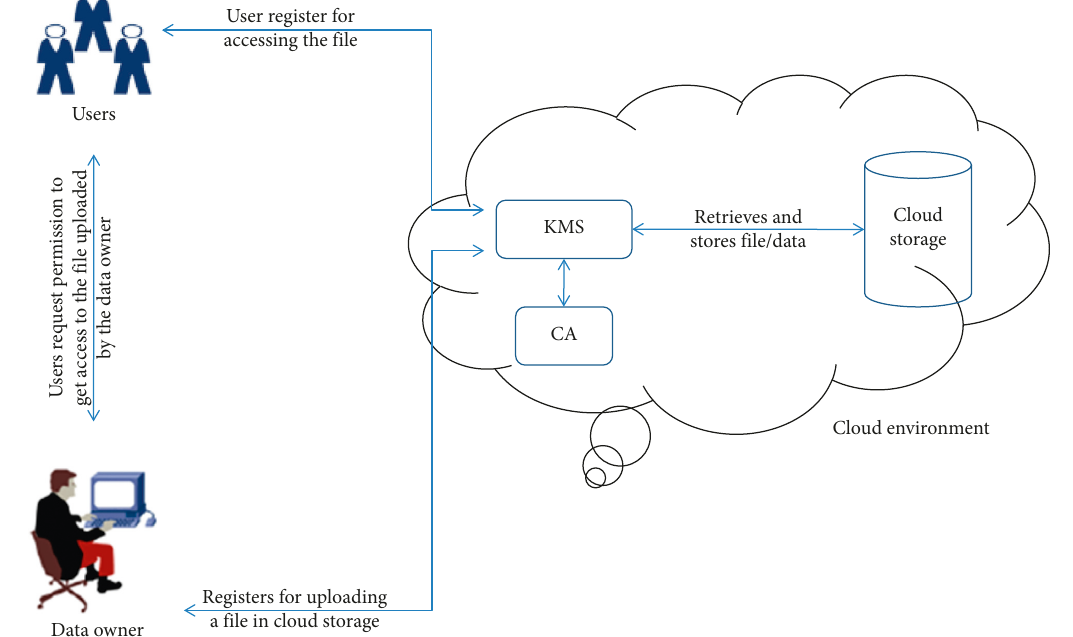
Figure 1: Block diagram of the proposed